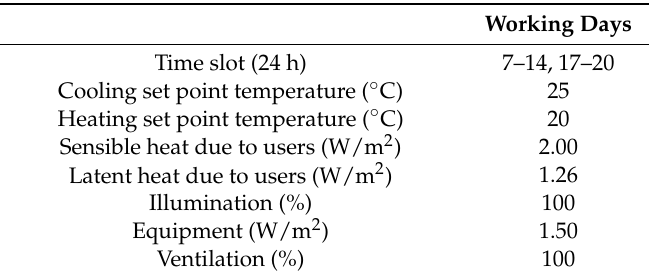
Table 4. Occupancy profile: non-residential, low intensity (12 h)